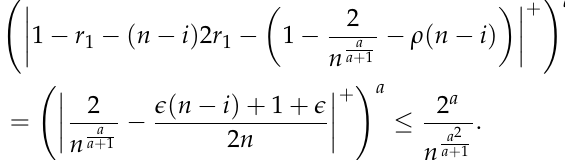
(cid:17) (cid:16) 1 n of rightmost sensors can a + 1